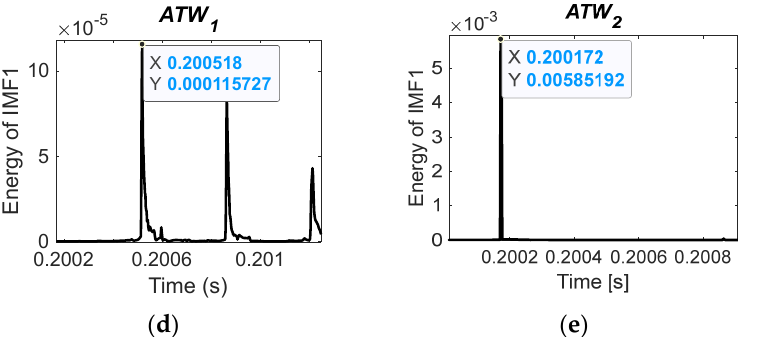
Figure 13. Real-time validation of EMD − based FLM. ( a ) Opal-RT experimental set-up. ( b ) Voltage at bus B1 measured by MSO. ( c ) Voltage at bus B2 measured by bus B2. ( d ) Estimated ATW at bus B1 by EMD-based FLM. ( e ) Estimated ATW at bus B2 by EMD-based FLM.